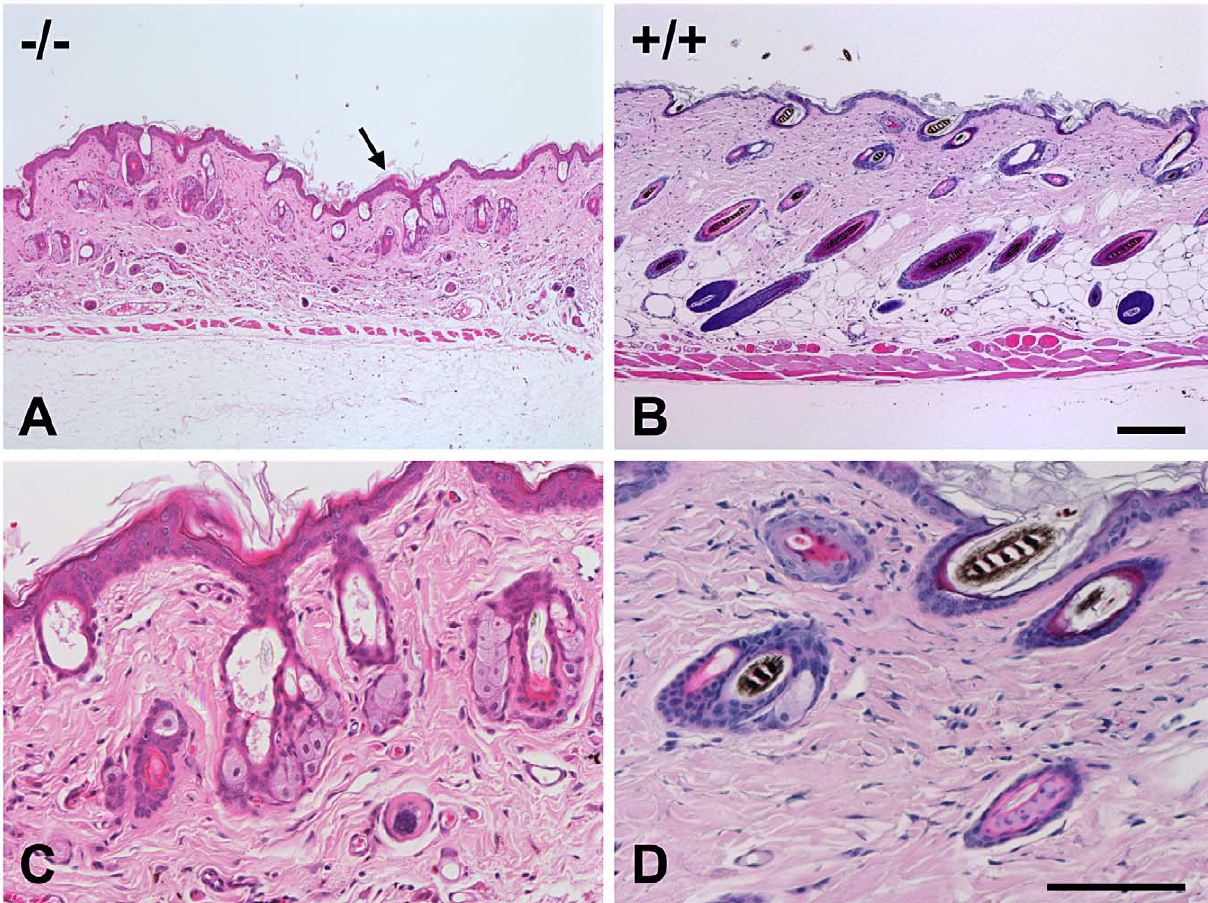
Figure 5. Histopathology analysis of amyloid in skin of an affected mouse. Skin sections were stained with H&E (A) and Congo red (B); and the latter stained section was also observed using a polarizing microscope (C). Note that amyloid deposits appeared eosinophilic by H&E stain, pink- red in Congo red stain, and showed yellow-green birefringence under a polarizing microscope.